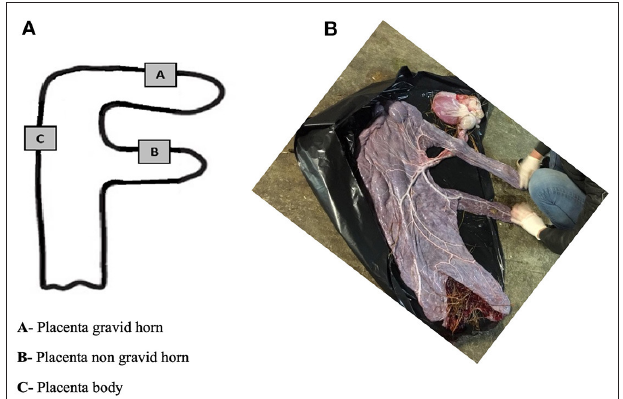
FIGURE 1 | Diagrammatical representation of the placenta sites for sample collection (A) . Photo of the allantoic surface of a mare’s placenta after delivery (B)